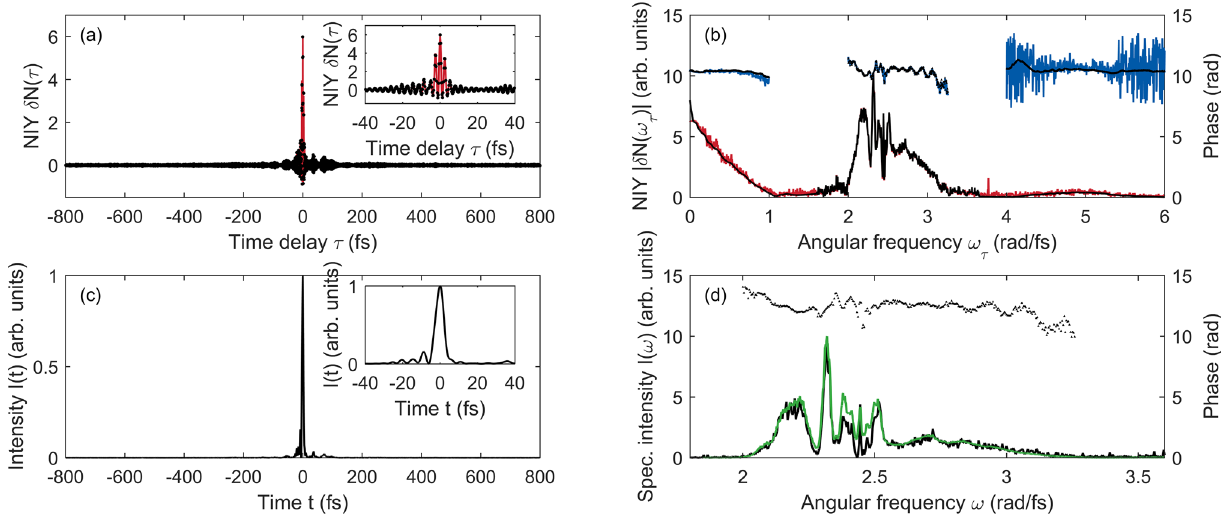
Figure 5. Reconstruction of few-cycle laser pulses obtained in an experiment. ( a ) The experimental NIY (red line) and the reconstructed NIY (black dots) in the time domain. The same plot for a short range of the time delay is shown in the inset. ( b ) The spectral amplitude (red line) and phase (blue line) of the experimental NIY and that (black dots and triangles) of the reconstructed NIY. ( c ) The reconstructed intensity profile in the time domain. The same plot for a short range of the time delay is shown in the inset. ( d ) The spectral intensities (black line) and phases (triangles) of the reconstructed spectrum. The spectral intensity of the spectrum obtained using a spectrometer